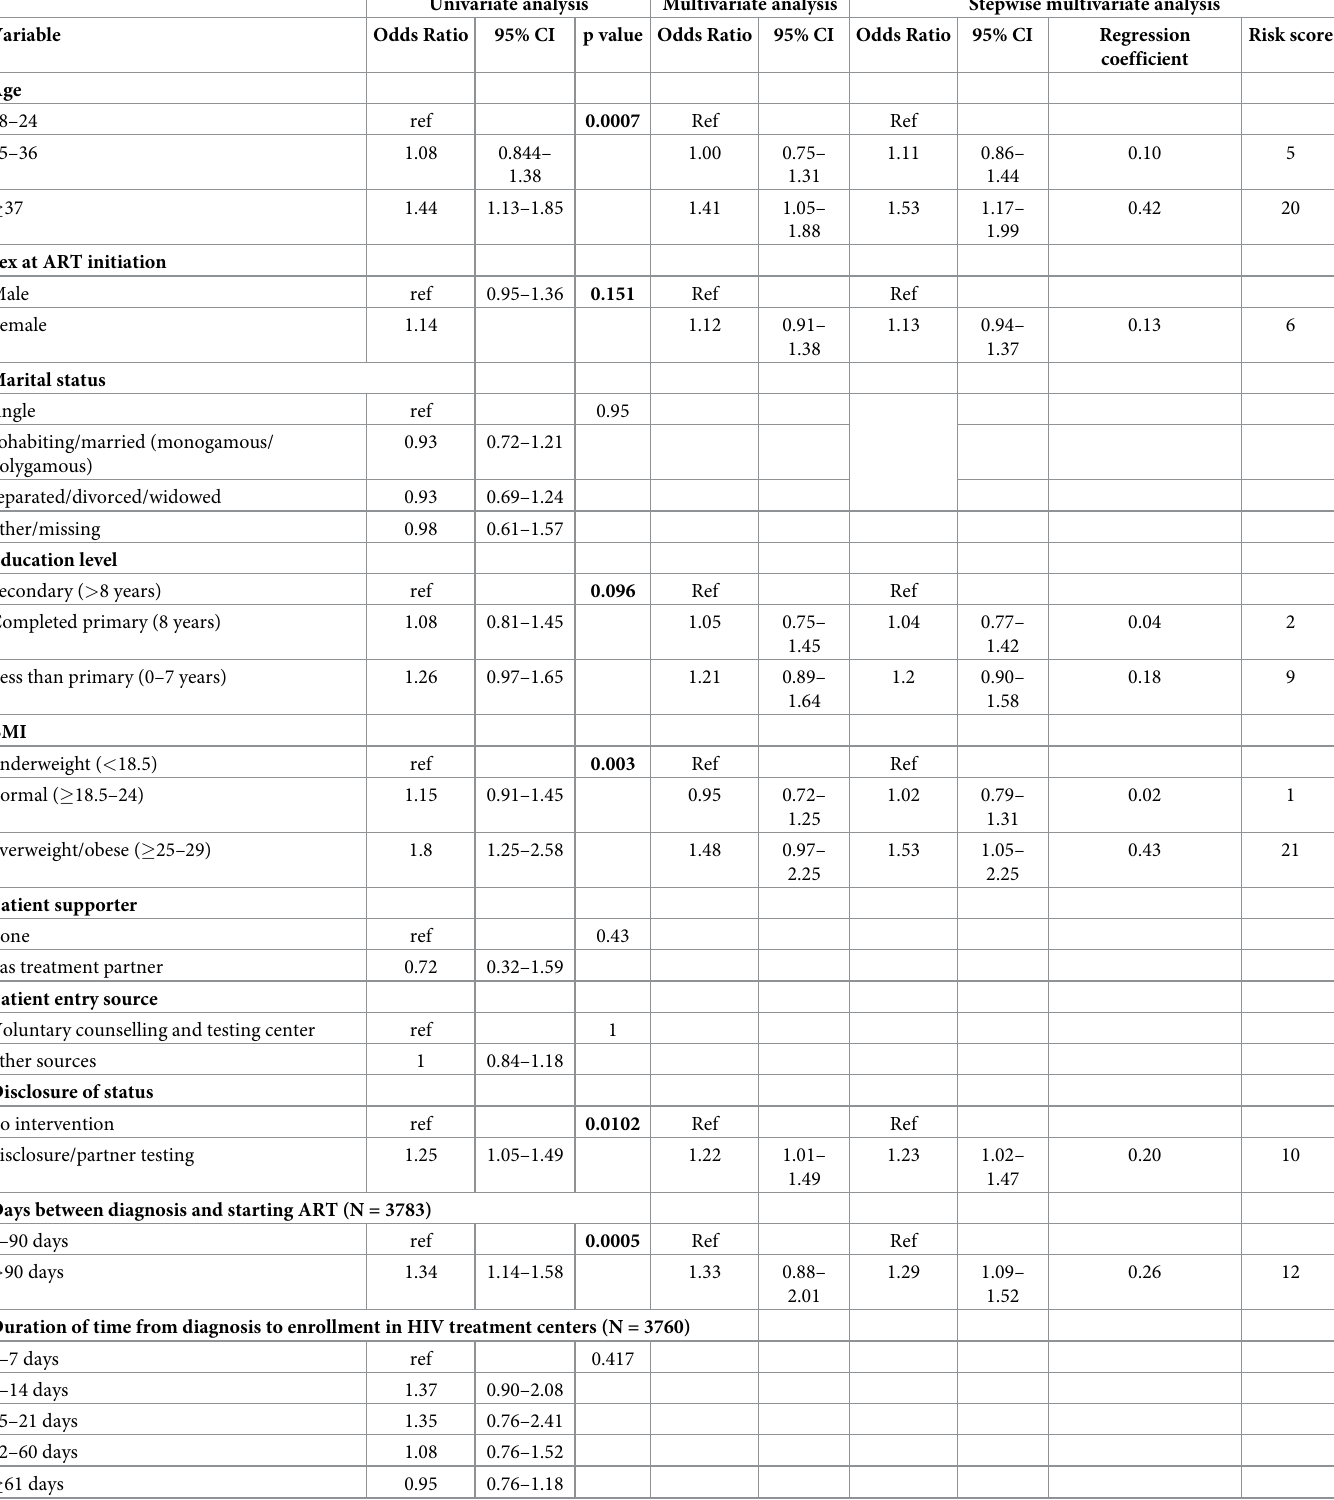
Table 2. Predictors of unsuppressed viral load at 18 months and calculation of risk